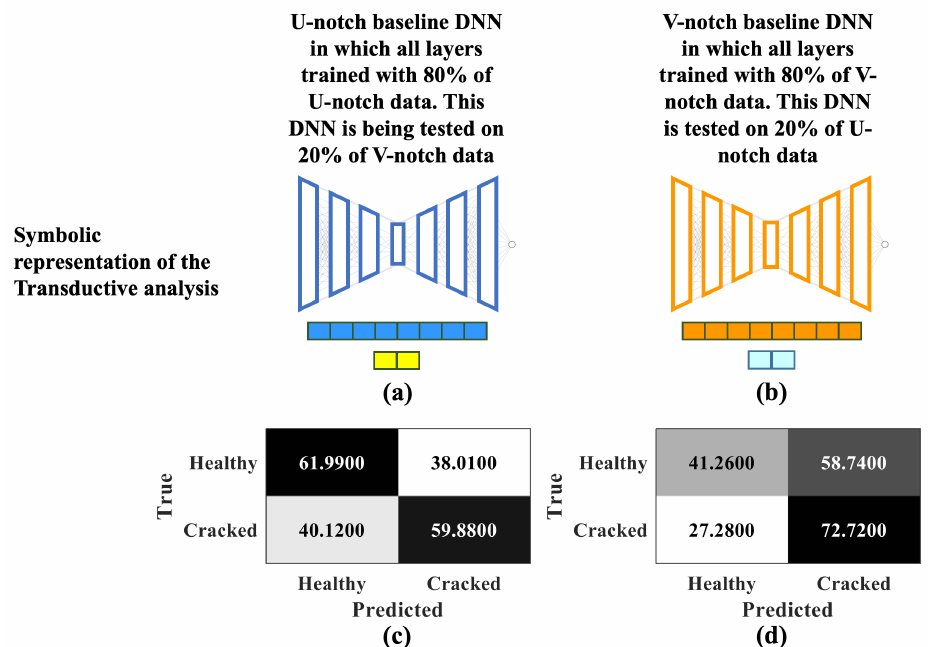
Figure 7. Overview of the transductive analysis framework: ( a ) the baseline U-notch DNN is tested on the V-notch test data and ( b ) the baseline V-notch DNN is tested on the U-notch test data. ( c ) Confusion matrix for ( a ). ( d ) Confusion matrix for ( b ).